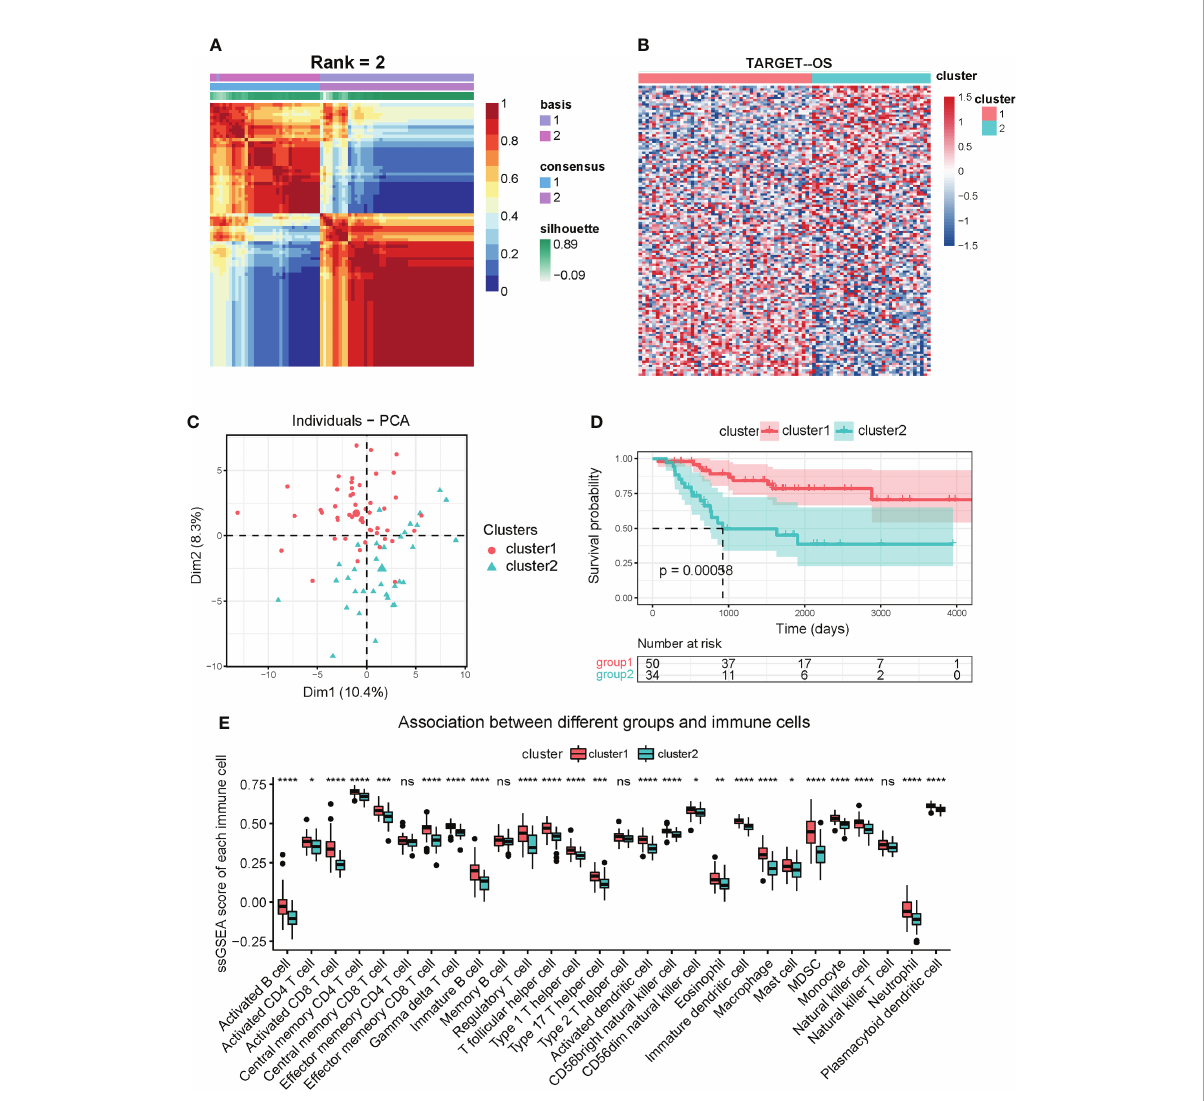
FIGURE 2 Identi fi cation of OS subclusters by unsupervised NMF clustering with ferroptosis regulators in TARGET OS cohort. (A) NMF clustering heatmap based on 132 ferroptosis genes (MAD > 0.5). NMF clustering divided 84 OS patients into two subclusters (we observed clearest boundary and most appropriate consistency when the coexistence correlation coef fi cient k = 2). (B) Heatmap of expression of the 132 ferroptosis regulators in two subclusters. Red represents high expression level and blue represents low expression. The darker the color, the greater the signi fi cance. (C) PCA scatter diagram supporting that NMF clustering algorithm divided OS patients into two subclusters. (D) Kaplan-Meier analysis for overall survival of OS patients in two subclusters. (E) Box diagram of ssGSEA analysis revealing expression of 28 immune cells in two subclusters. Kruskal test * P < 0.05; ** P < 0.01; *** P < 0.001; **** P < 0.0001; ns, no signi fi